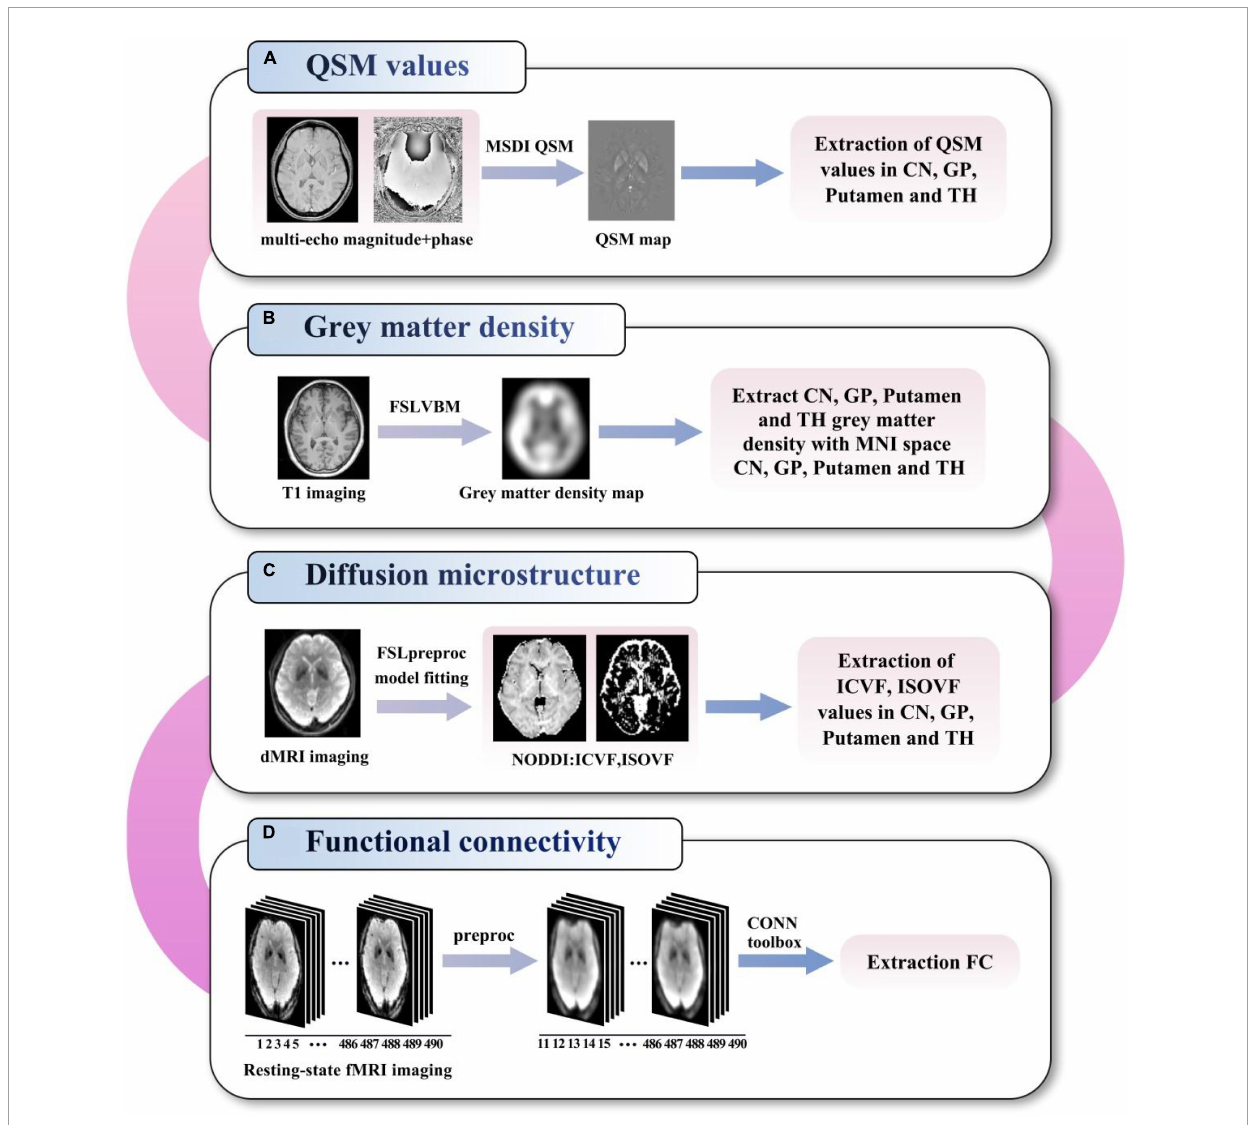
FIGURE1 Flowchart of the imaging analysis of QSM values (A) , grey matter density (B) , diffusion microstructure (C) , and functional connectivity (D) . QSM, quantitative susceptibility mapping; MSDI, multi-scale dipole inversion; VBM, voxel-based morphometry; MNI, Montreal neurological institute; NODDI, neurite orientation dispersion and density imaging; ICVF, intracellular volume fraction; ISOVF, isotropic volume fraction; FC, functional connectivity; CN, caudate nucleus; GP, globus pallidus; TH,